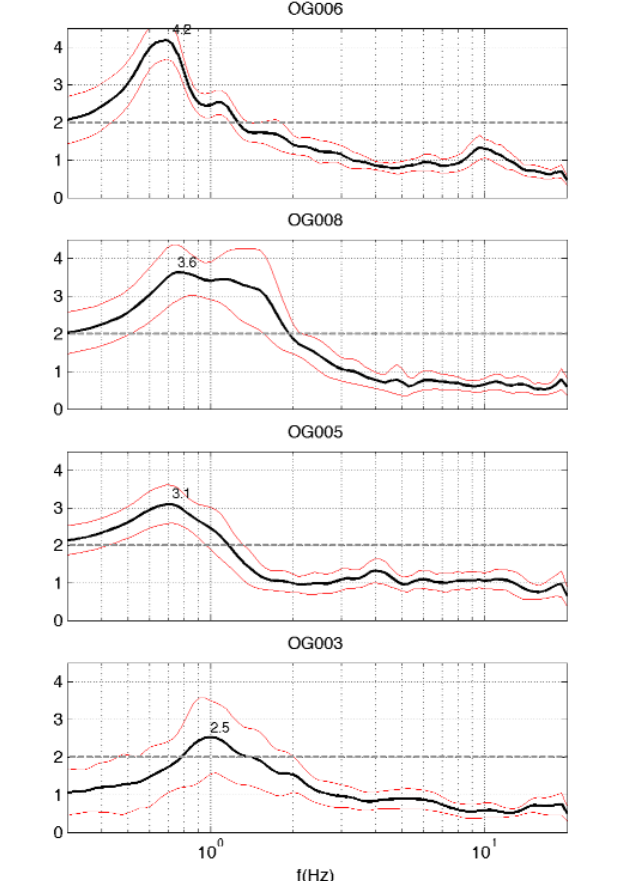
Figure 4. Single station seismic noise HVSRs estimated along the two tran- sects shown in Figure 3. Transect 1 (right) runs in the SW-NE direction and includes stations OG003, OG005 (about 6 km out of line), OG008 and OG006. Transect 2 (left) runs in the SE-NW directions and includes sta- tions OG001, OG007, OG002, OG006 and OG004. The H/V peak value is specified for each curve.